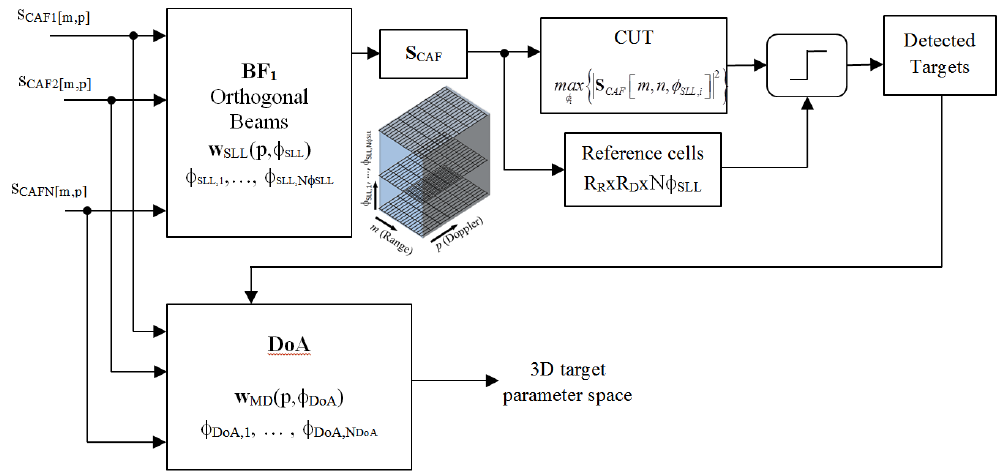
Figure 14. Two-stage frequency-domain spatial filtering